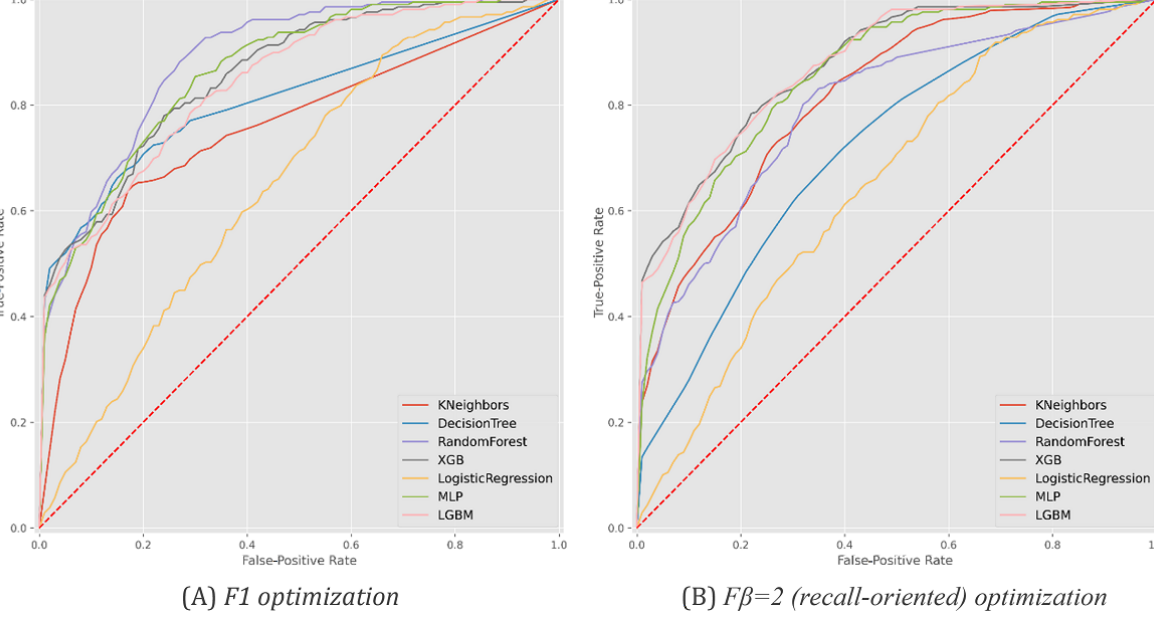
Figure 7. Receiver operating characteristic curves with the predictive behavior of the selected classifiers in predicting intensive care unit admission needs at the time of hospitalization. XGB: XGBoost, MLP: multilayer perceptron, LGBM: